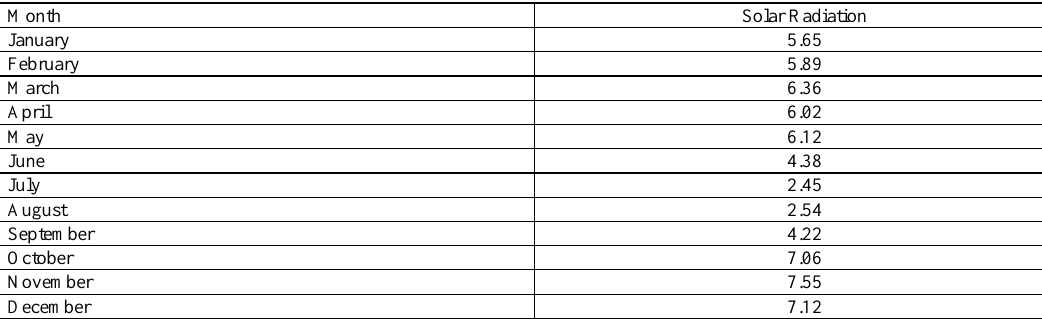
Table 3. Solar radiation in KW-hr/m 2